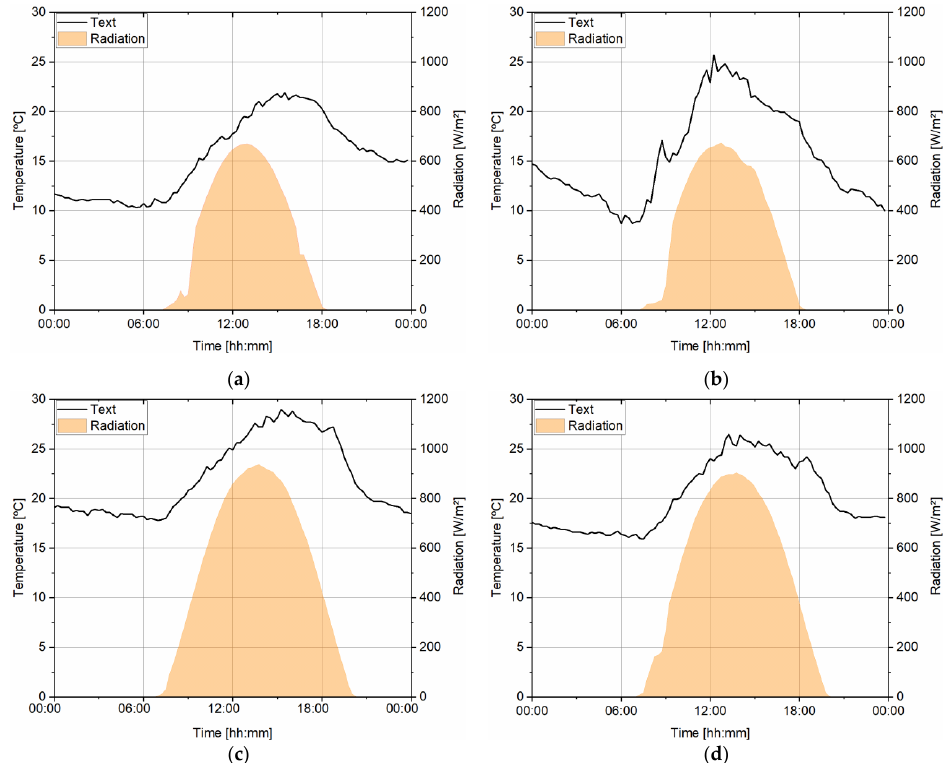
Figure 6. Environmental conditions during prototype testing: ( a ) February 21st, ventilated air cavity; ( b ) February 24th, non-ventilated air cavity; ( c ) August 22nd, non-ventilated air cavity; ( d ) August 30th, ventilated air cavity.